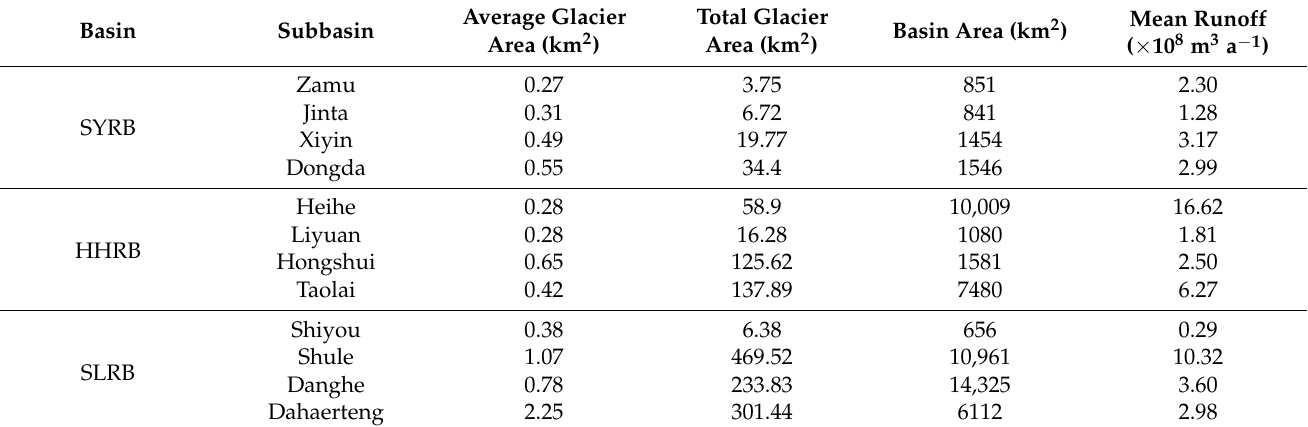
Table 1. Features of 12 subbasins and the glaciers in each